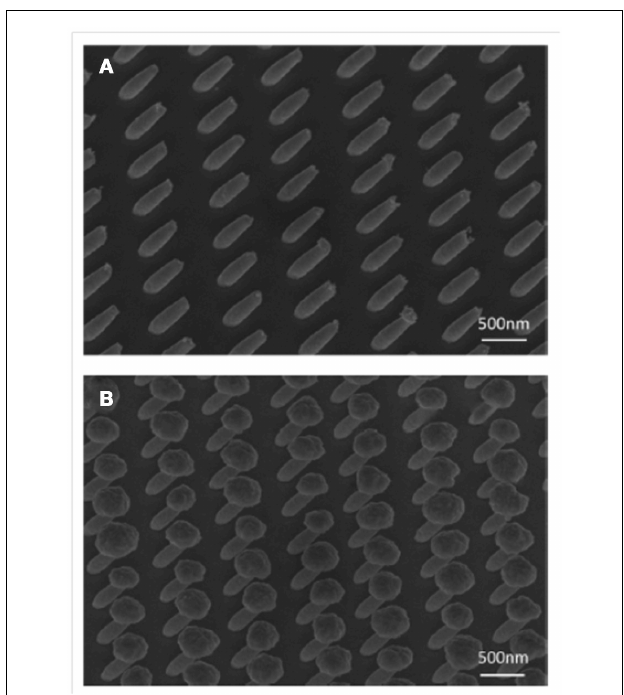
FIGURE 8 | SEM images of 45° tiltedAu pillar arrays by electroplating into tilted hole arrays in electron beam resist . (A) Tilted pillars of 300nm diameter and 750nm length without Au over-plating. (B) Mushroom-shaped Au pillar array due to over-plating.The images were taken at 45° viewing angle. From Zhang et al. (2012).